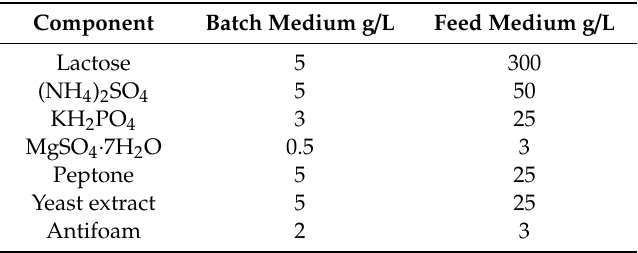
Table 1. Composition of the batch and feed